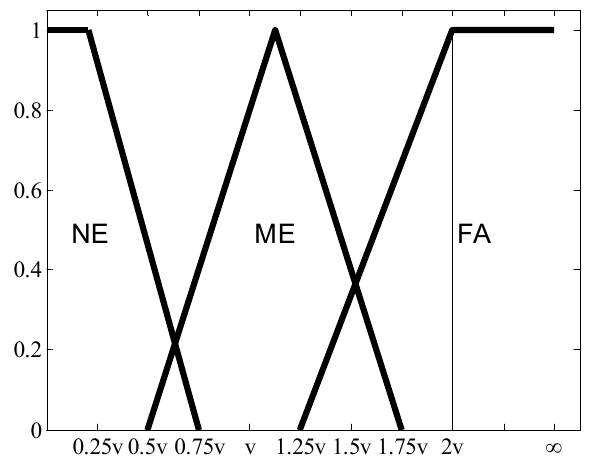
Figure 5. Membership functions of fuzzy sets in distance 𝑆 (cid:3038) ( v is the current target velocity).